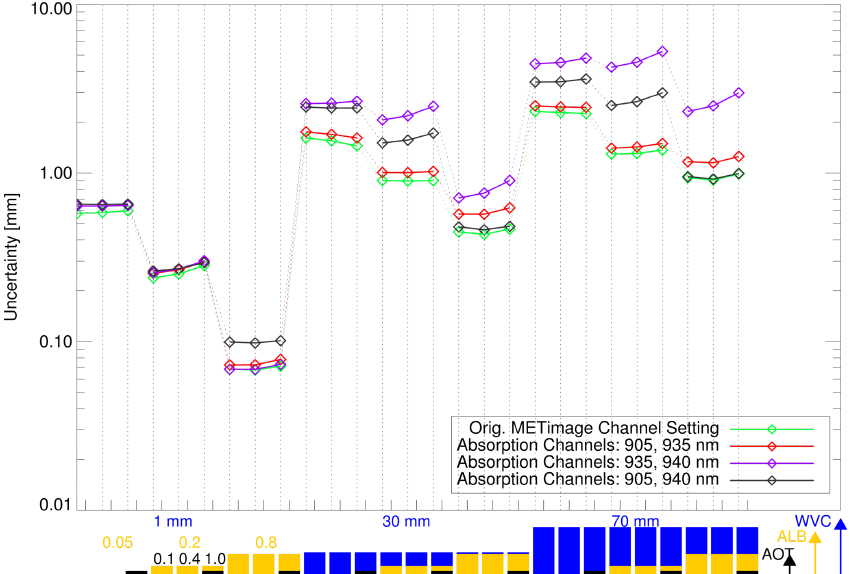
Fig. 7. Uncertainties in mm of water vapour retrievals using two absorption channels and two window channels (METimage concept) for 27 different cases of a combination of three atmospheric properties: total column water vapour (TCWV), albedo (ALB), and aerosol optical thickness (AOT).